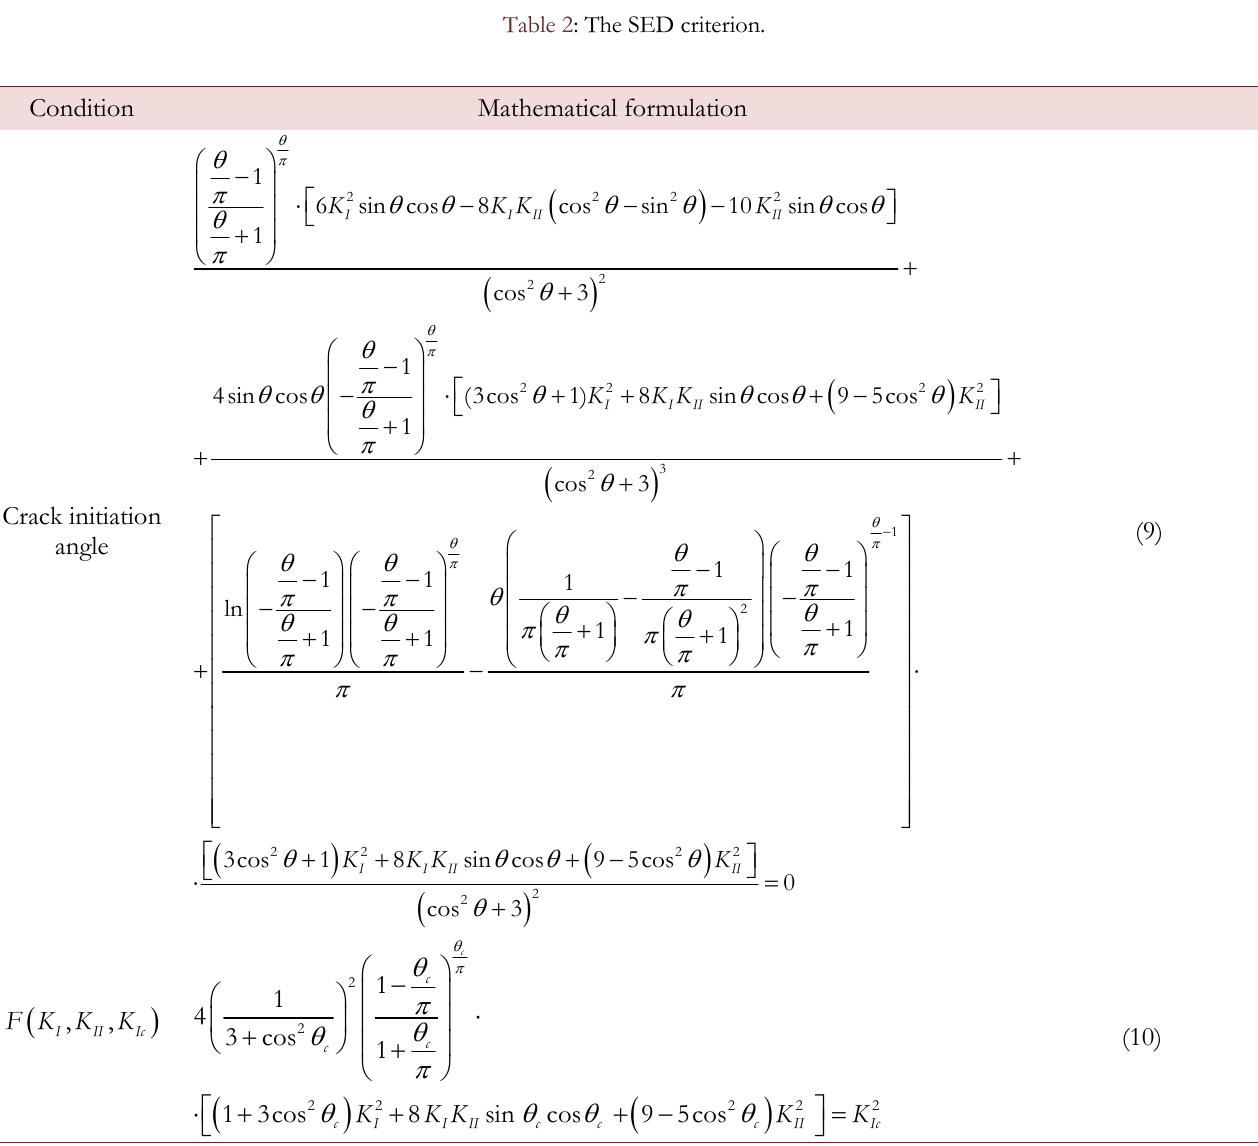
Table 3: The Gmax